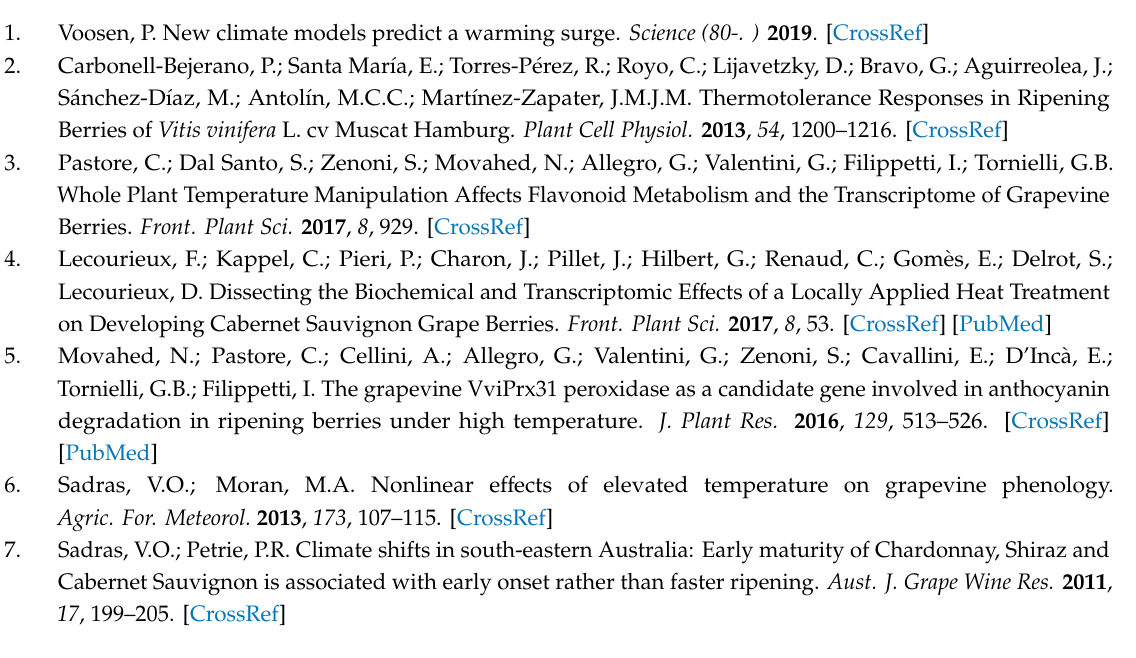
Table S1: Summary values (mean, standard error and n) for traits showing significant di ff erences between the 21 ‘Malbec’ clones: days from flowering to veraison (DFV), cluster weight (CW) and berry number (BN), Figure S1: Phenological events recorded during the growing season. Temperature conditions during the 2018–2019 season (orange line) and historic (last 17 years, blue